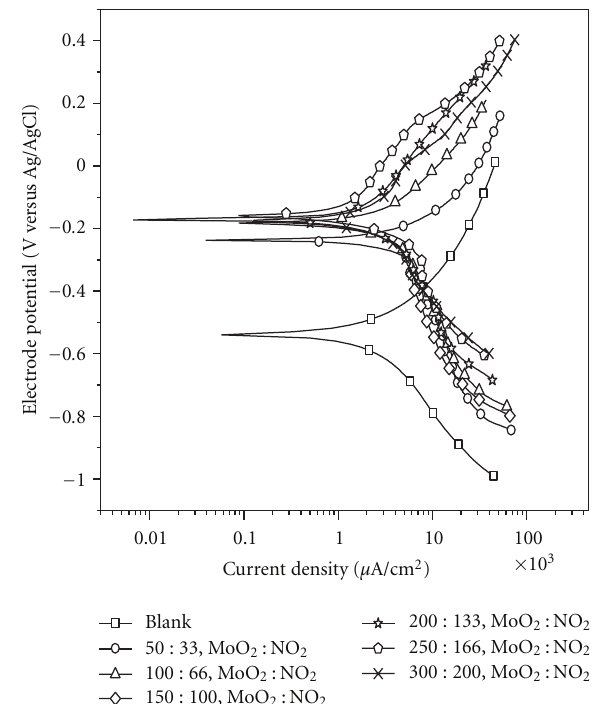
Figure 5: Current potential polarization plots for the Cu-CS galvanic couple as a function of Na 2 MoO 4 :NaNO 2 concentration, in a 1.5 :1 ratio.